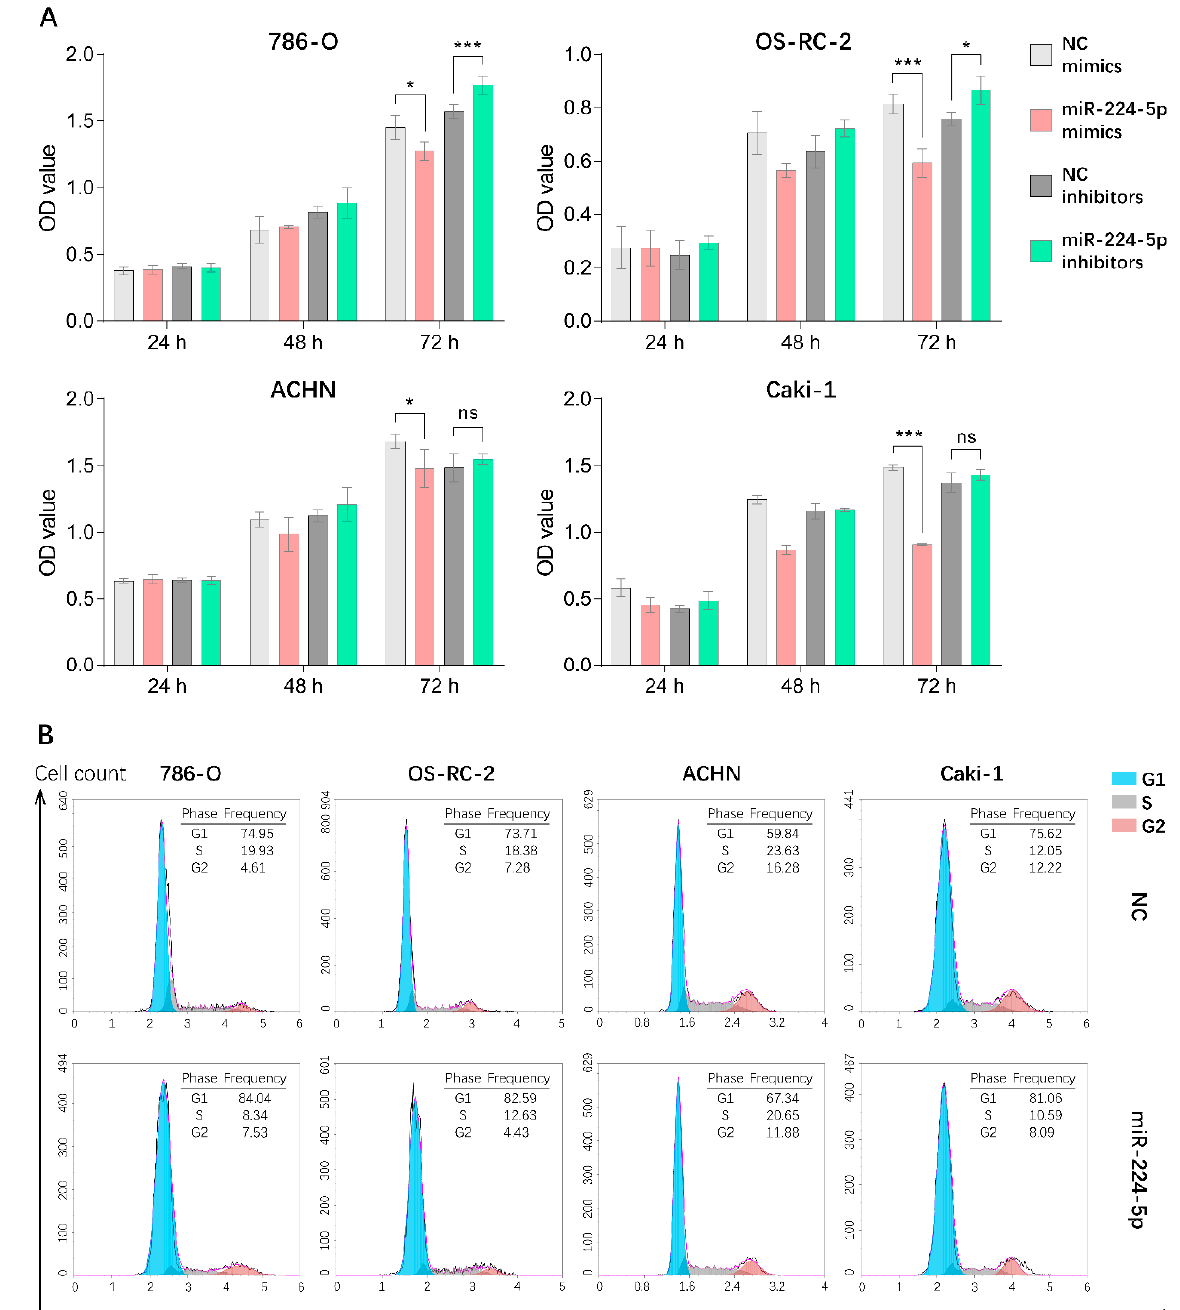
Figure 4. miR-224-5p inhibited RCC cell proliferation and induced cell cycle arrest. ( A ) Cell proliferation of miR-224-5p mimic/inhibitor-transfected RCC cells was detected by CCK-8 assay. Data are mean ± s.e.m. * p < 0.05; *** p < 0.001; ns, no significant difference. ( B ) Cell cycle distributions after transfection of miR-224-5p mimics into RCC cells were determined by flow cytometry. The frequency of each cell cycle phase is listed in figure.